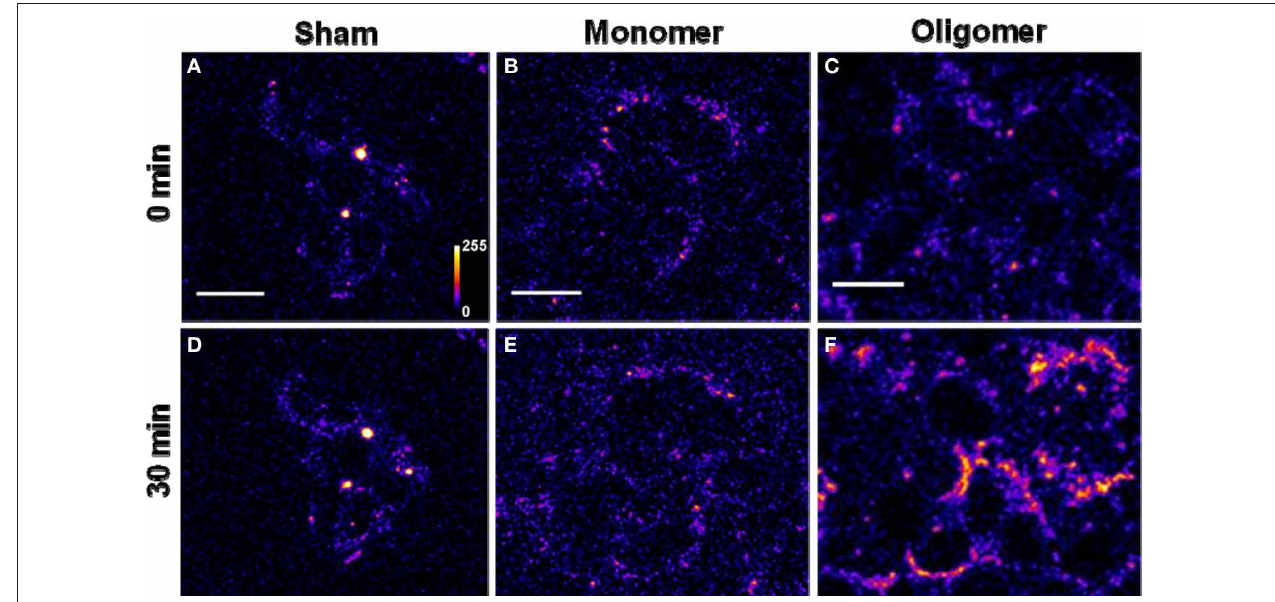
FIGURE 1 | Binding of A β 40 monomers and oligomers to HEK293T cell membranes. (A–C) Confocal sections of three sets of cells (excitation 543nm, emission 550–700nm). (D–F) Corresponding sets of cells after